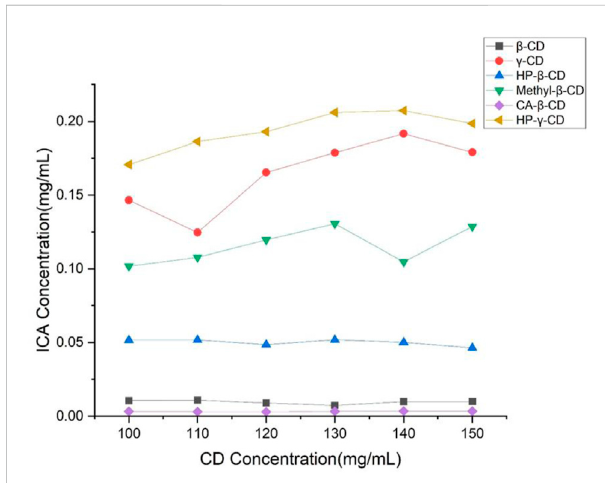
FIGURE 2 Phase solubility curves of icariin with β -cyclodextrin, HP- β - cyclodextrin, methyl- β -cyclodextrin, citric acid- β -cyclodextrin, γ - cyclodextrin and HP- γ -cyclodextrin.